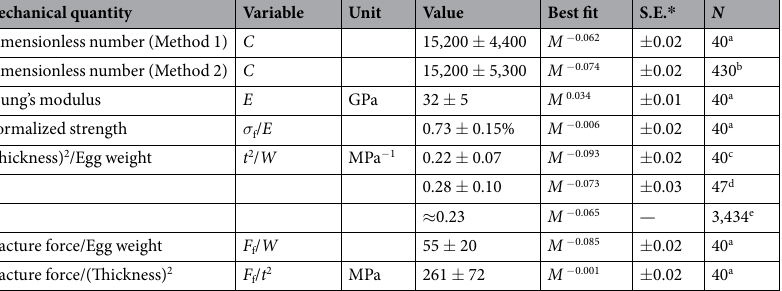
Table 2. Mechanical qantities exhibiting allometric invariances, and their corresponding values and allometric exponents. a Experimental results based on 400 freshly laid egg samples (Method 1). b Numerical results based on published egg images and data, assuming E = 30 GPa. (Method 2). c Present study, thickness does not include membranes. d Ar et al . 9 , thickness includes dried membranes. e Ar et al . 9 , based on the data in Handbuch der Oologie 16 ; thickness was estimated from the eggshell mass and surface area. t 2 / W = 0.23 (evaluated at W = 10 g); elephant birds t 2 / W = 0.16 and W = 9,120 g; vervain hummingbirds t 2 / W = 0.33 and W = 0.34 g. * Standard error of the exponent of the best fit. N : Number of species.